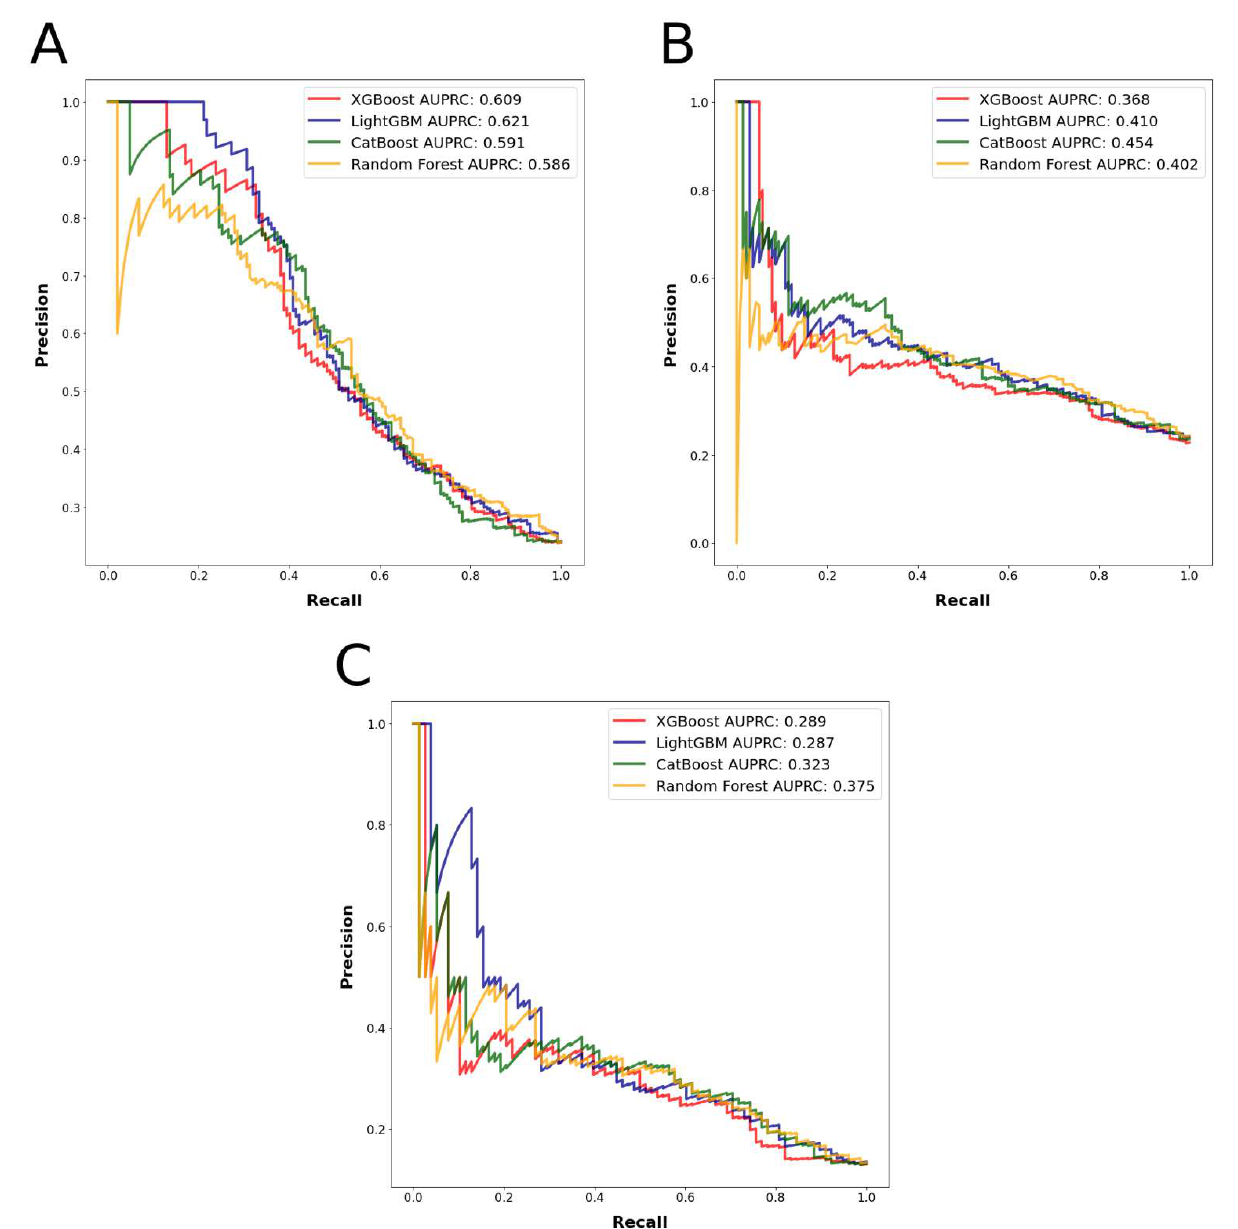
Figure 4. ( A ): Algorithms’ precision–recall curves for the outcome prolonged length of stay. ( B ): Algorithms’ precision–recall curves for the outcome nonhome discharges. ( C ): Algorithms’ precision–recall curves for the outcome major complications. SHAP plot of the XGBoost model for the outcome prolonged LOS, the CatBoost model for the outcome nonhome discharges, and the random forest model for the outcome major complications are presented in Figure 5. The other SHAP plots can be seen in Figure